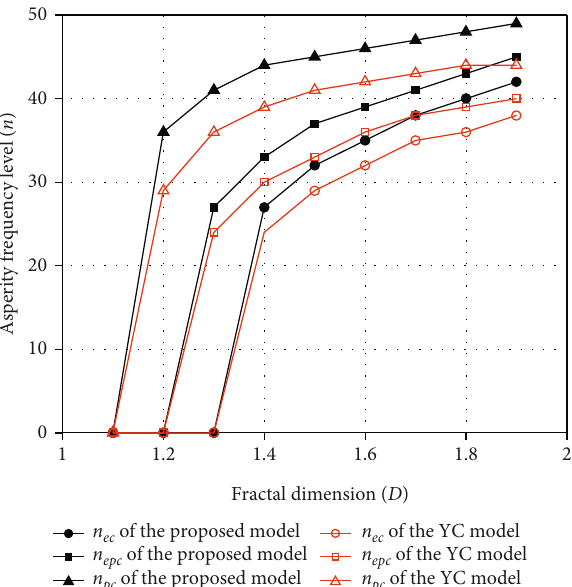
Figure 6: Comparison of the YC model and the proposed model on the critical frequency levels at different fractal dimensions A � 0 . 4). D ( G � 2 . 5 × 10 − 9 m, A r / a